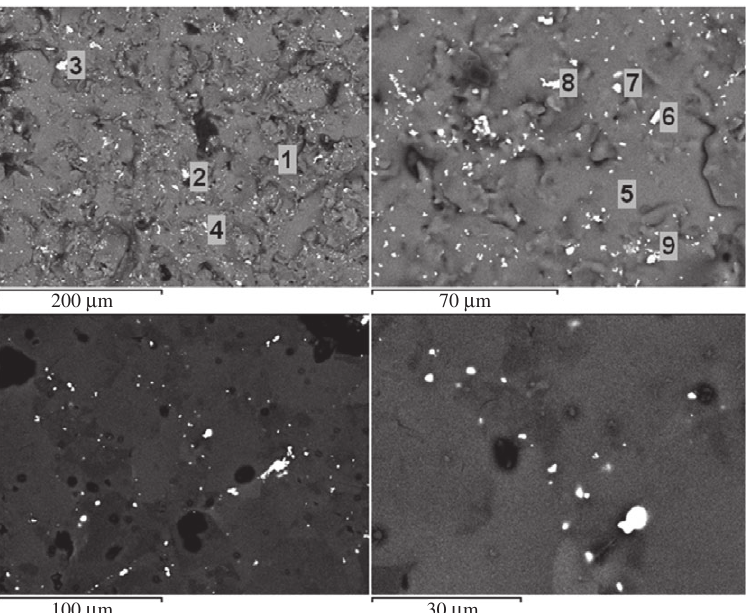
Figure 1 SEM surface (top) and cross-sectional (bottom) images of the surface of dental porcelain specimens. The numbers correspond to representative areas on the surface of dental porcelain, which were measured by using EDS analysis (Table